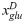
Model. IID2. Short-term synaptic depression.A: field potential. B: short-term synaptic depression variables xgluD and xGABAD. C: the membrane current at Vh = −27mV in a representative excitatory neuron. The simulation corresponds to that in Fig 9.